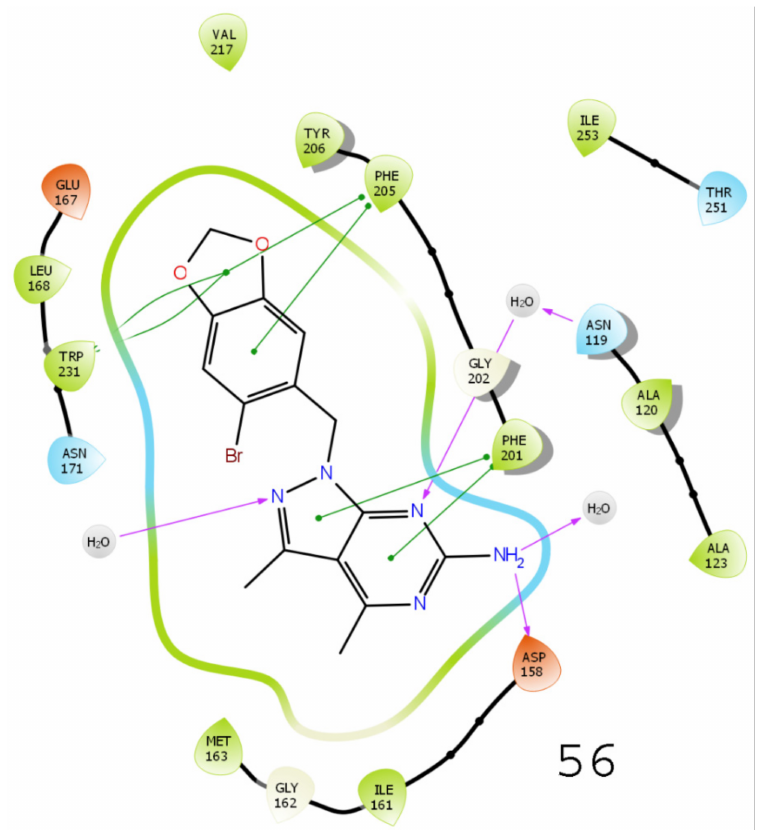
Figure 8. A 3D diagram showing binding interactions of compounds 43 and 56 with TRAP1 (PDB ID: